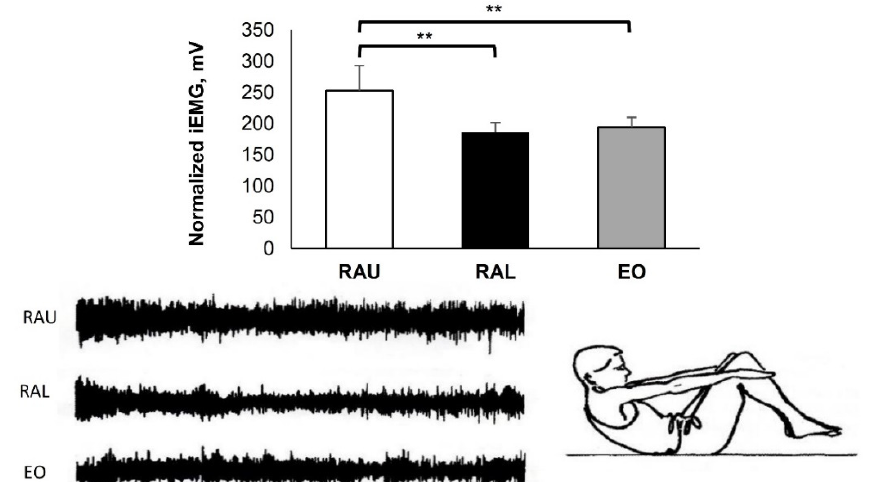
Figure 5. Hook lying with arms elevated forward and feet above the floor. Slow curl-up with rounded back to approximately 35–40°, with isometric contraction for 10 s. Group mean electric activity during the exercise. iEMG indicates surface electric activity. Raw EMG activity of the three muscles from one participant. RAU = rectus abdominis upper part; RAL = rectus abdominis lower part; EO = external oblique. Differences between muscles: ** p < 0.01.